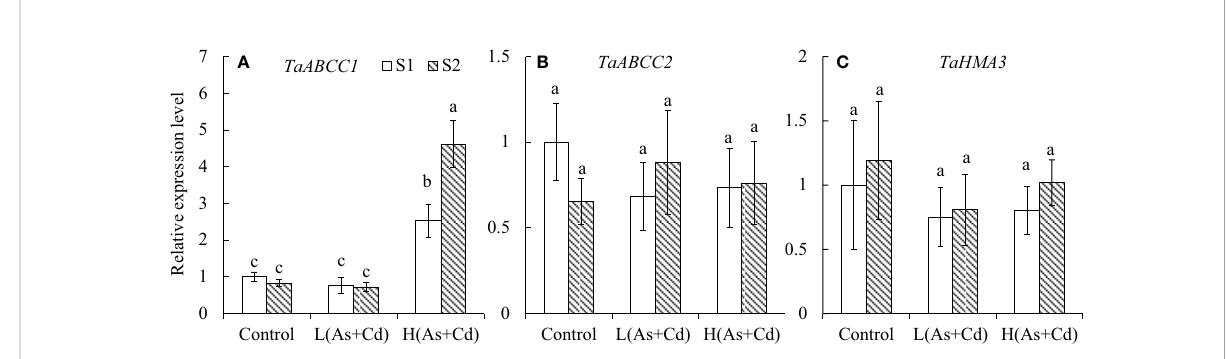
FIGURE 3 Expression levels of TaABCC1 (A) , TaABCC2 (B) , and TaHMA3 (C) in the roots of wheat plants grown in low S or high S nutrient solution after 6 days of As plus Cd exposure. S1, de fi cient sulfate; S2, suf fi cient sulfate; L(As+Cd), low As plus Cd; H(As+Cd), high As plus Cd. Data are means ± SD ( n = 3). Different letters in the same column indicate signi fi cant differences among treatments at p ≤ 0.05 according to Duncan ’ s multiple comparison